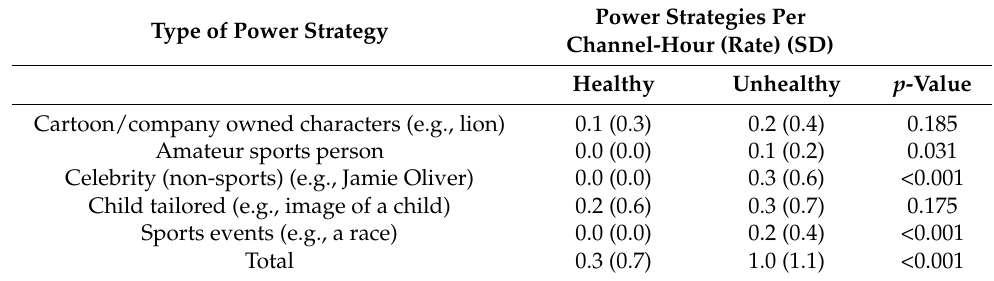
Table 6. Mean rates of power strategies. Power Strategies Per Type of Power Strategy Channel-Hour (Rate) (SD) Healthy Unhealthy p -Value Cartoon/company owned characters (e.g., lion) 0.1 (0.3) 0.2 (0.4) 0.185 Amateur sports person 0.0 (0.0) 0.1 (0.2) 0.031 Celebrity (non-sports) (e.g., Jamie Oliver) 0.0 (0.0) 0.3 (0.6) <0.001 Child tailored (e.g., image of a child) 0.2 (0.6) 0.3 (0.7) 0.175 Sports events (e.g., a race) 0.0 (0.0) 0.2 (0.4) <0.001 Total 0.3 (0.7) 1.0 (1.1)